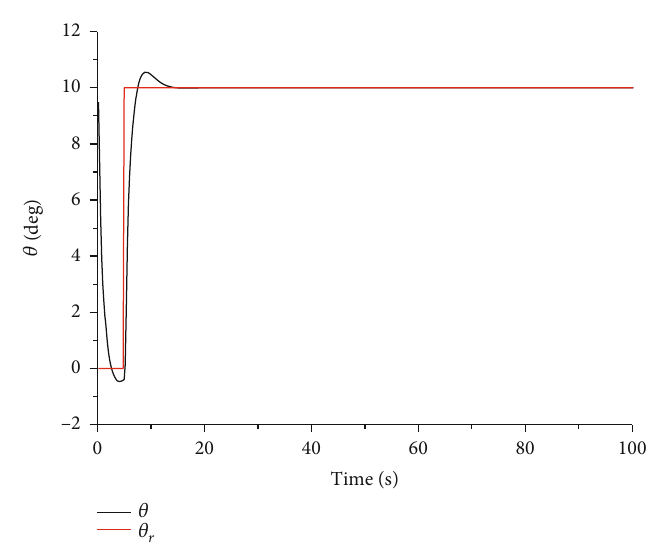
Figure 27: Pitch with attitude control for the maximum glide